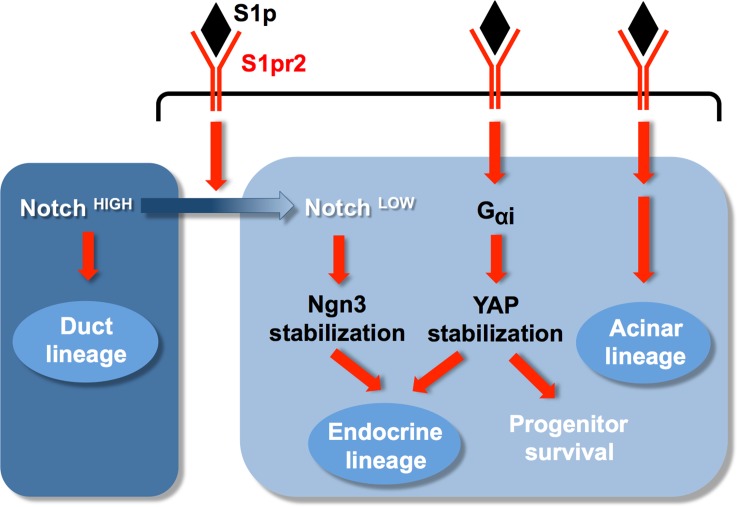
S1pr2 signalling regulates pancreatic lineage allocation and specification.S1pr2 signalling attenuates Notch signalling to promote the segregation of tip MPCs that will give rise to acinar progenitors and bipotent trunk progenitors and, in the latter, to promote the generation of endocrine progenitors via Ngn3 stabilisation. These are two temporally distinct steps shown here as one for simplicity. Ngn3 is stabilised post-translationally in Notchlow cells [19]. Additionally, S1p signalling stabilises YAP to enable progenitor survival. Gαi activation mediates the stabilisation of the YAP protein to enable endocrine specification. Both YAP stabilisation and Notch down-regulation are necessary for endocrine specification.